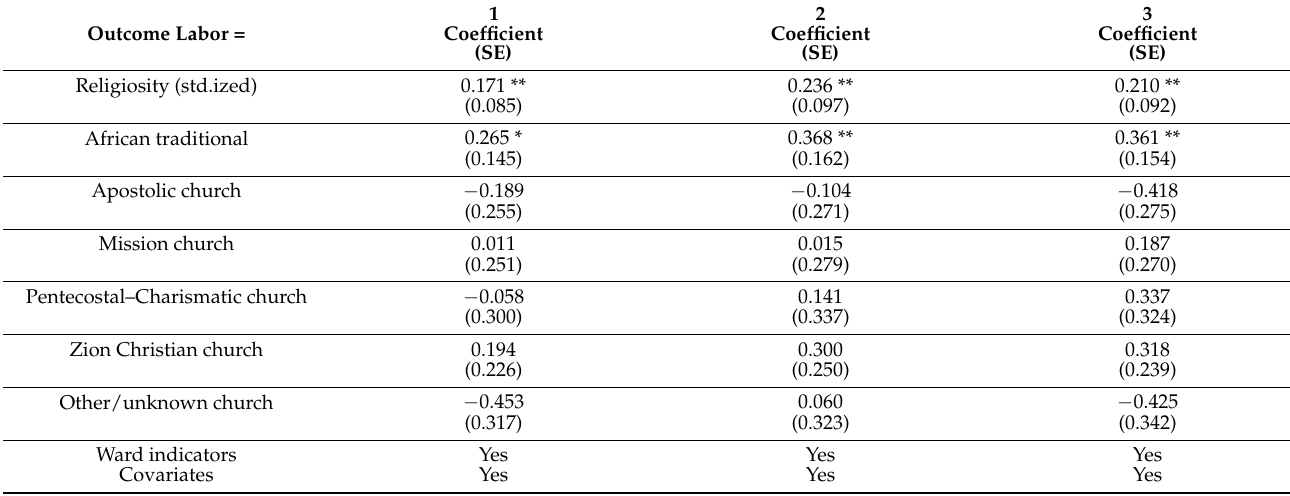
Table A3. Estimation results multinomial probit